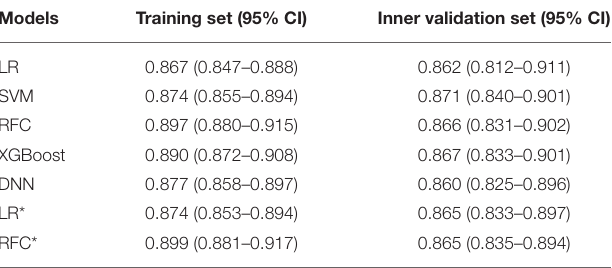
TABLE 2 | The area under the curve (AUC) of training set and inner validation set. Models